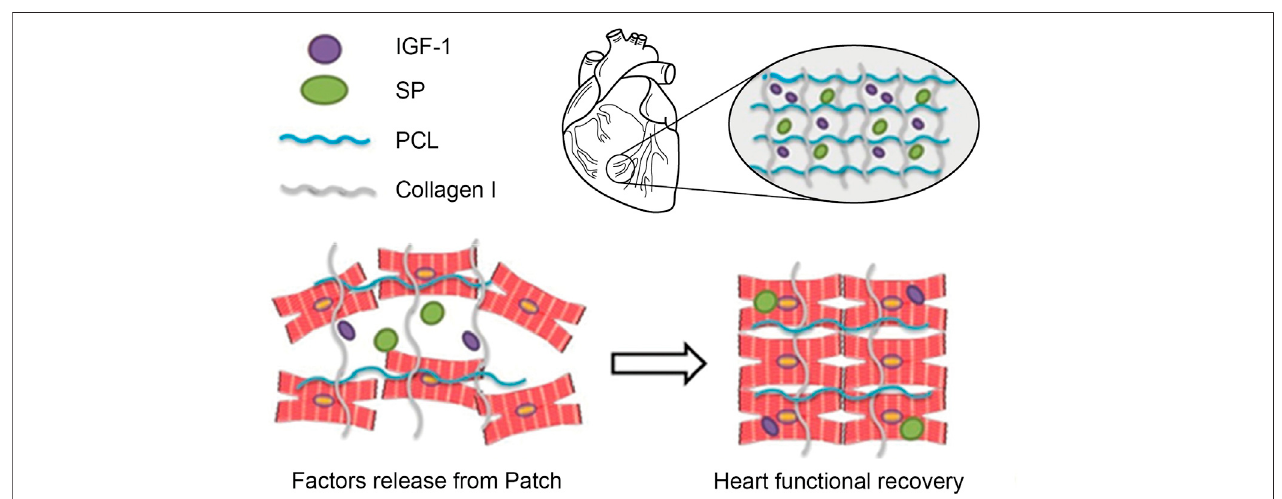
FIGURE 5 | Schematic illustration of MSCs Recruitment in vivo. Schematic diagram of the designed study. Cardiac patches containing SP alone or SP and IGF-1 peptideswerefabricatedbyelectrospinning.SPmayrecruitendogenousstemandprogenitorcells,whereasIGF-1peptidemayenhancetheirretentionandengraftment at the target site. Adapted with permission from (Sha fi q et al., 2018). Copyrights reserved Oxford Publishers.